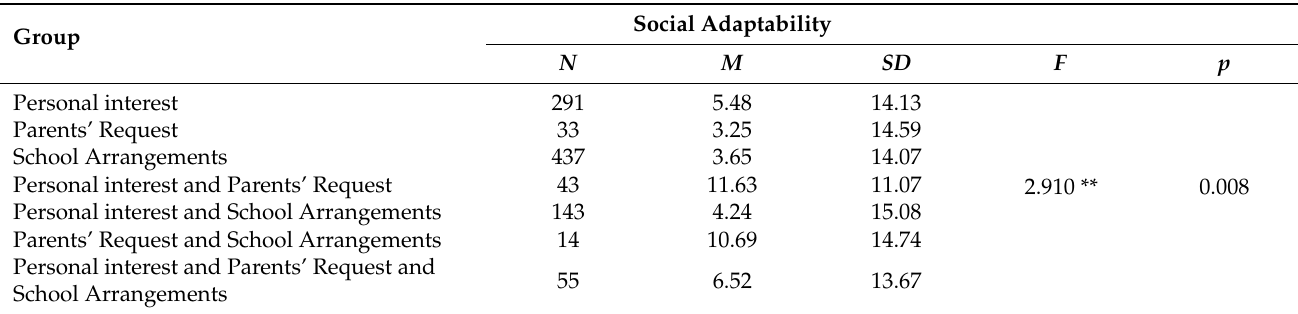
Table 6. Analysis results of social adaptability scores of students among different AI learning cause groups.